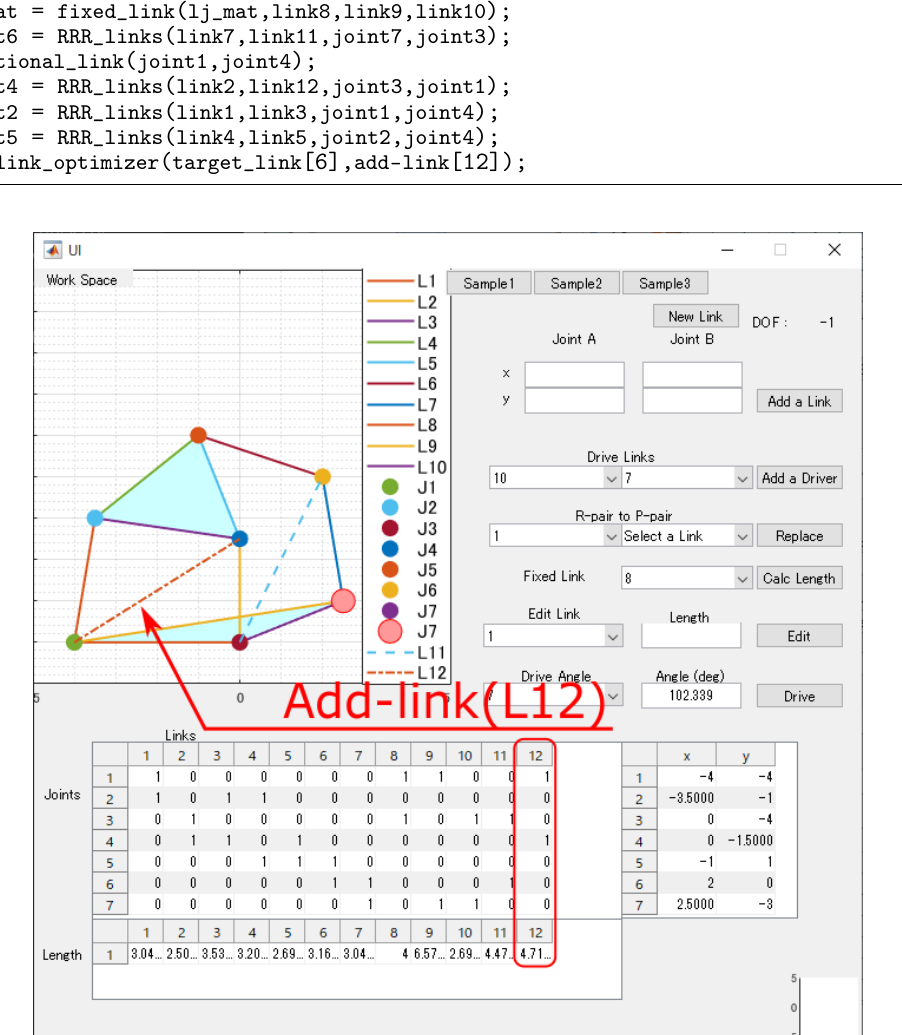
Figure 14. 6-bar linkage mechanism drawn on LJ-matrix generator GUI and installed